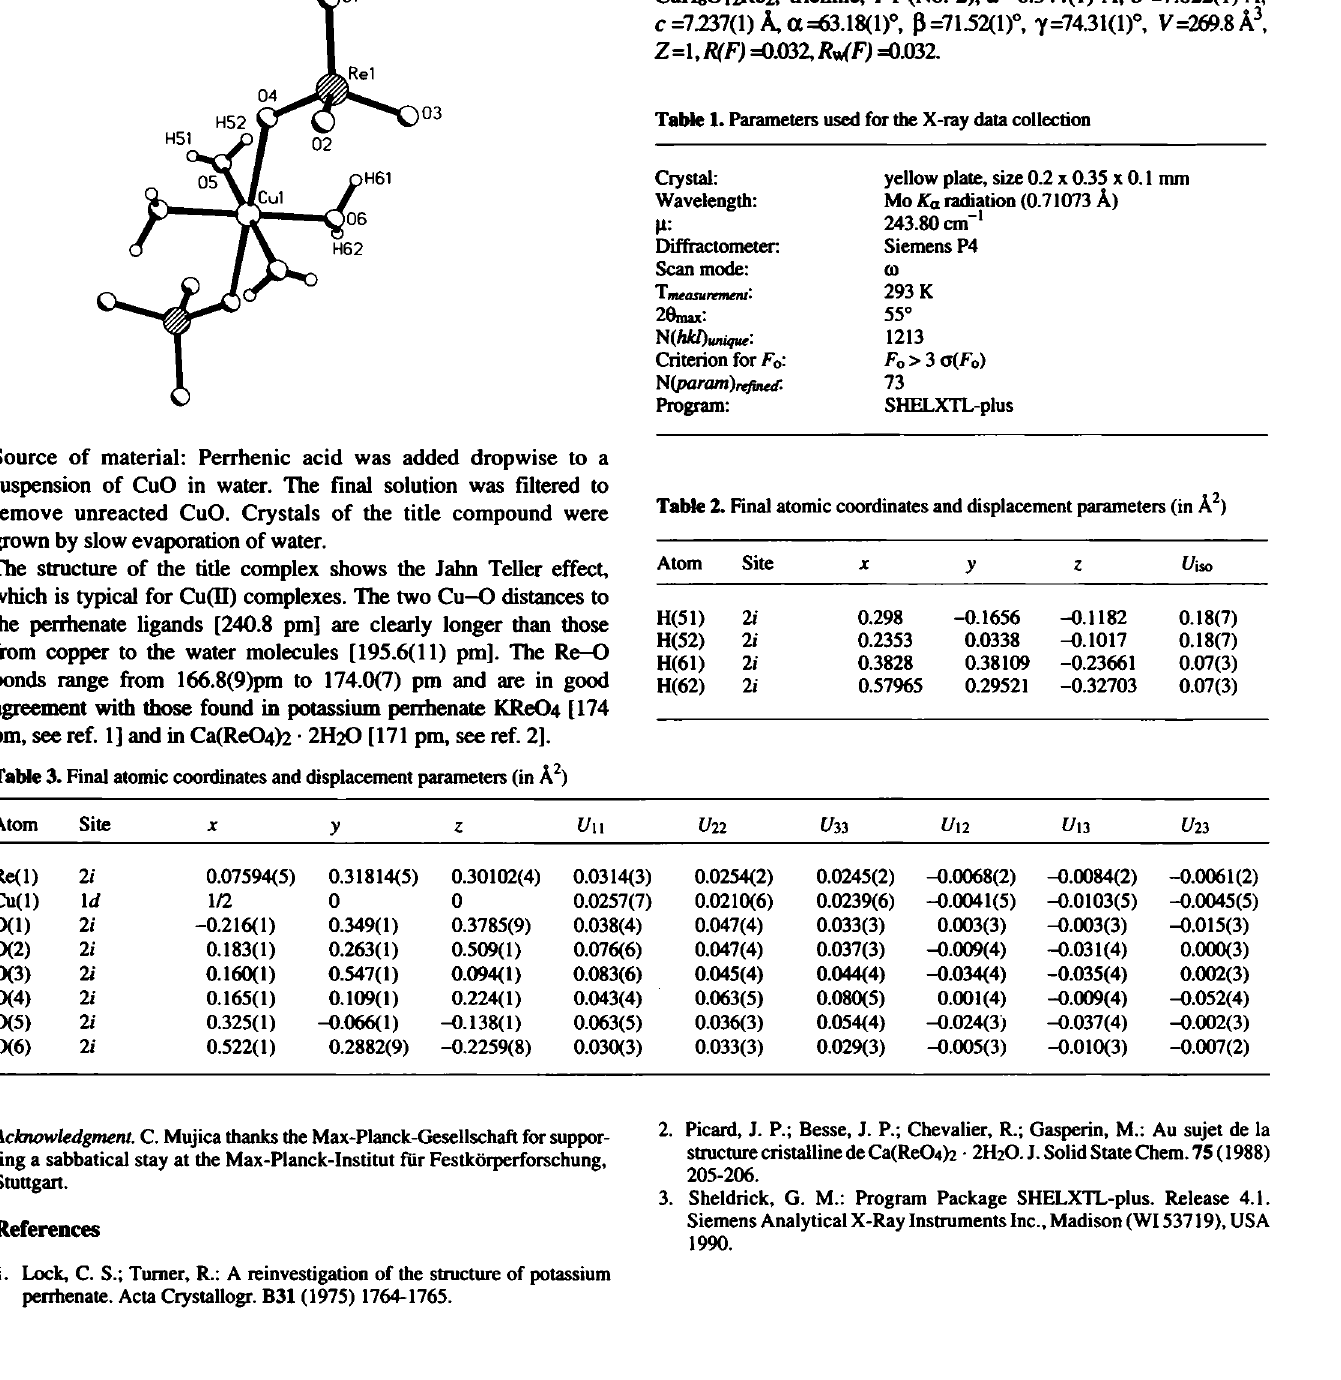
Table I. Parameters used for the X-ray data collection Crystal: